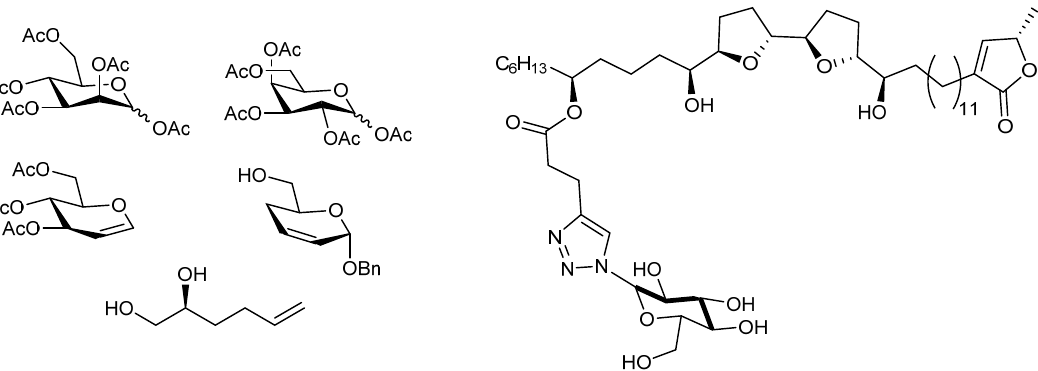
Figure 6. Carbohydrate precursors employed in the synthesis of Annona cherimola acetogenin mimics and mono-galactosylated squamocin.